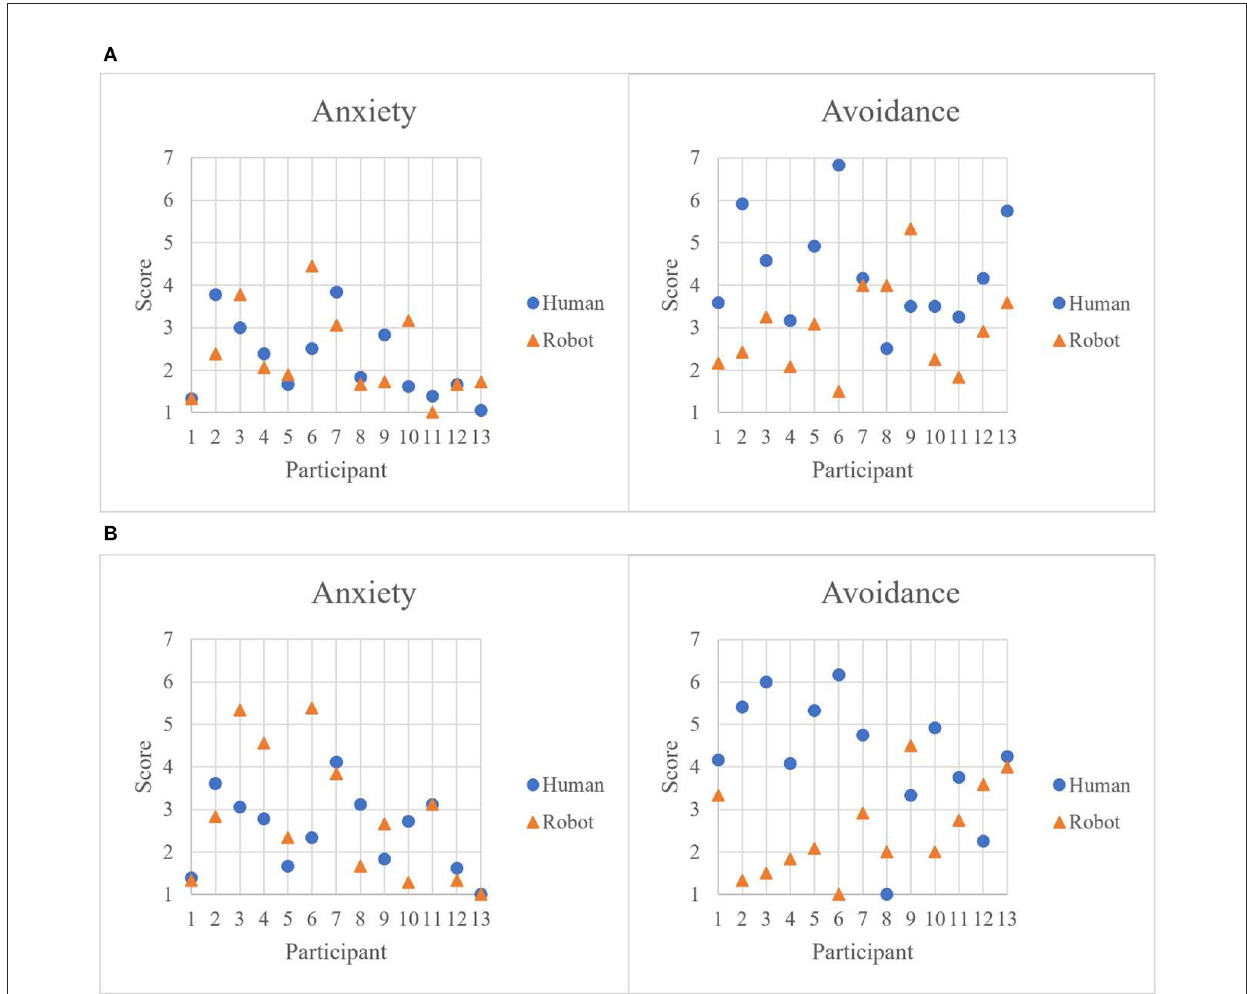
FIGURE4 (A) The “first” measurement results before the robot was taken away, showing each participant’s differences concerning attachment-related anxiety and avoidance toward both humans and robot. (B) The “second” measurement results after the robot was taken away, showing each participant’s differences concerning attachment-related anxiety and avoidance toward both humans and